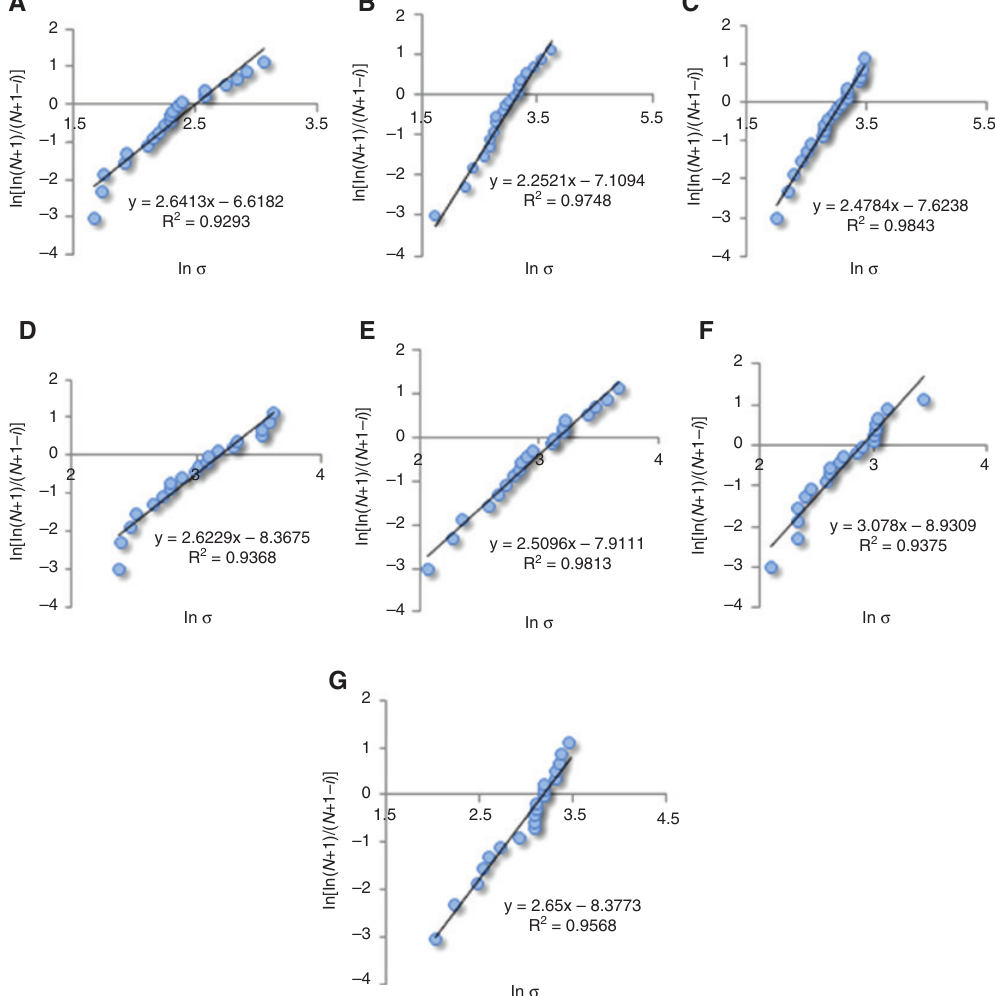
Figure 9: Weibull distribution of the tensile strength of DPFs: (A) R, (B) A1, (C) A2, (D) A3, (E) B1, (F) B2, and (G)